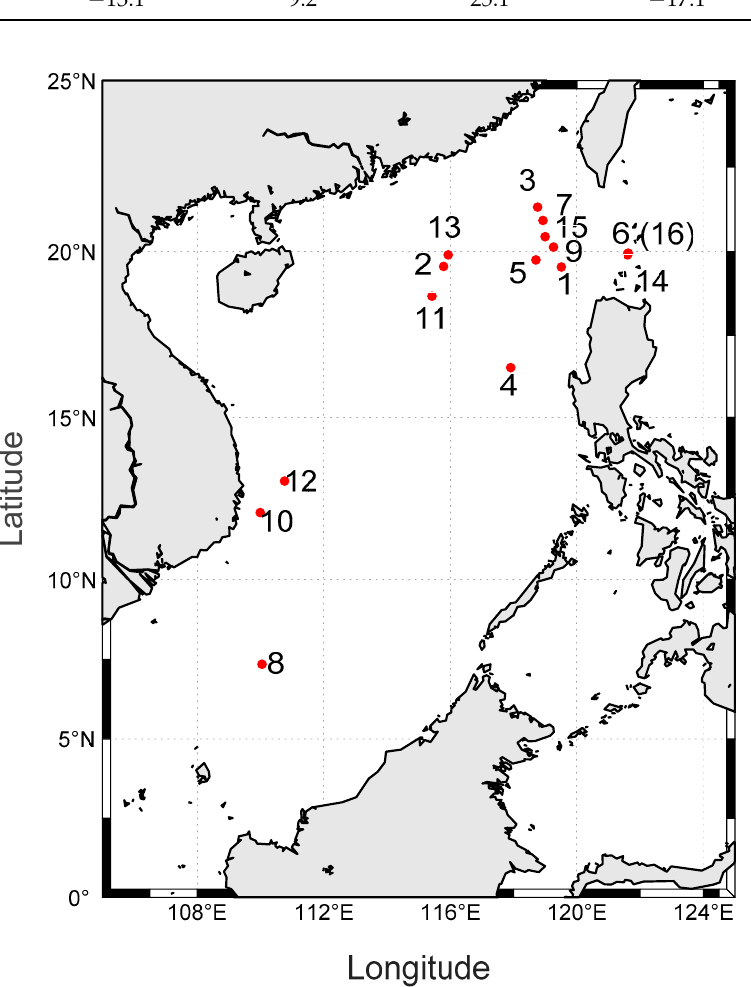
Figure 5. The map of the coordinates of the selected points. (Number 6 and 16 are located at the same position).